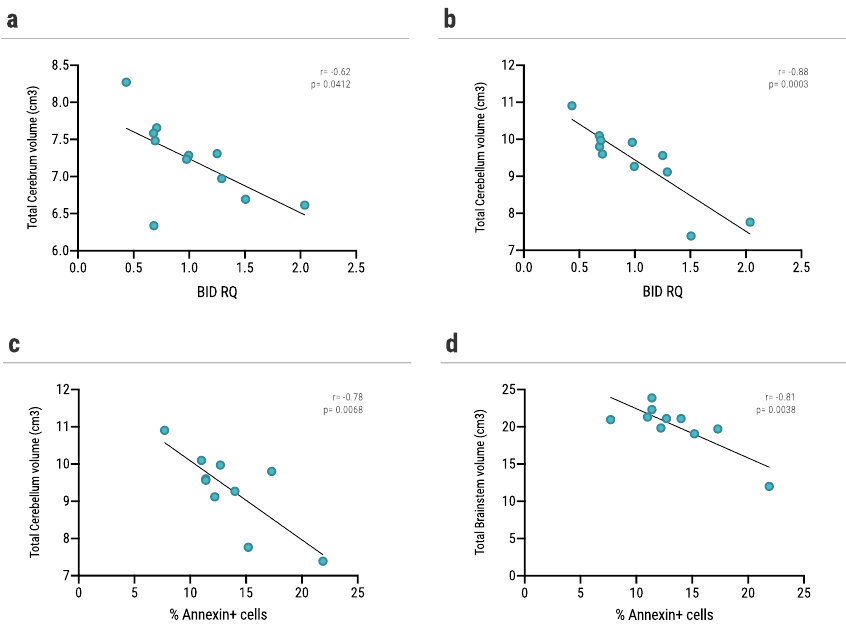
Figure 5. Correlation between BID and annexin levels in sera-cultured astrocytes and brain volume. ( a , b ) Correlation between BID RQ expression levels of mouse astrocytes following culture with sera of AQP4+ patients and ( a ) total cerebrum volume (r = − 0.62, p = 0.0412), ( b ) total cerebellum volume (r = − 0.88, p = 0.0003), ( c , d ) correlation between annexin levels of mouse astrocytes following culture with sera of AQP4+ patients and ( c ) total cerebellum volume (r = − 0.78, p = 0.0068), ( d ) total brainstem volume (= − 0.81, p = 0.0038). Correlation was determined by Pearson correlation test. Differences were considered significant at p < 0.05.